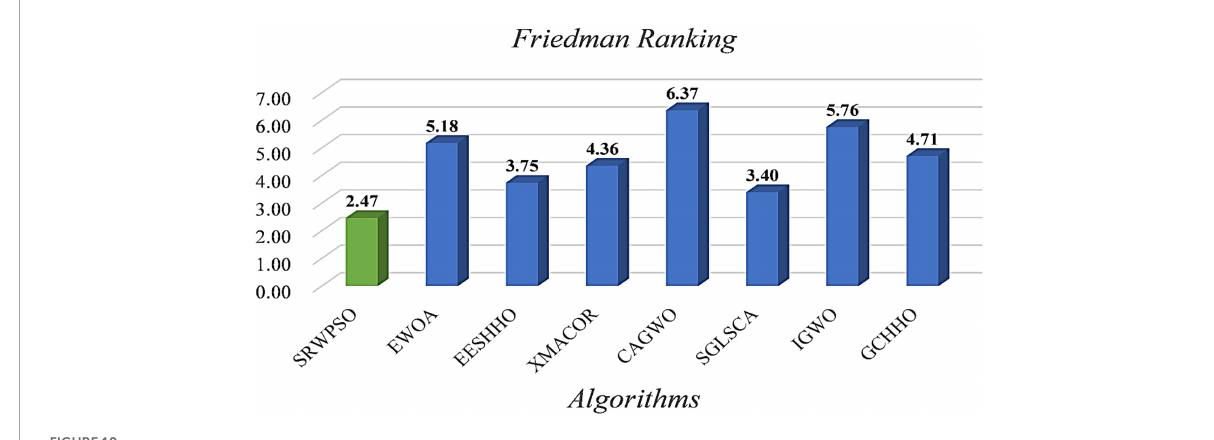
FIGURE10 The results of Friedman test of SRWPSO with famous variants.